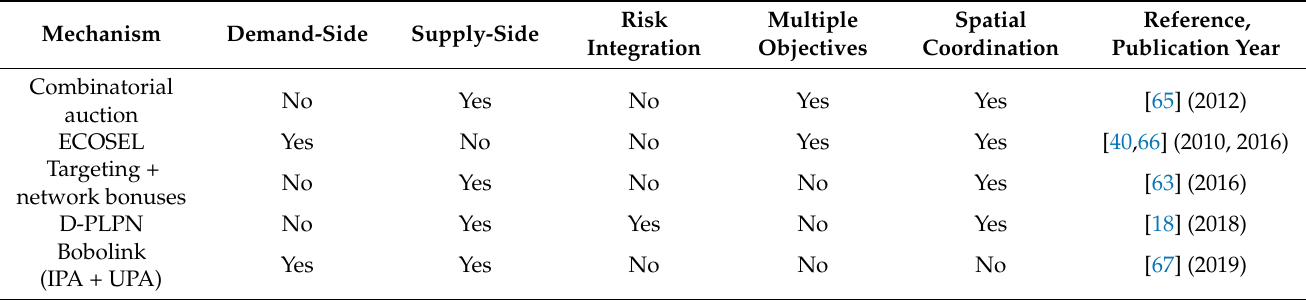
Table 1. Comparison of selected mechanism